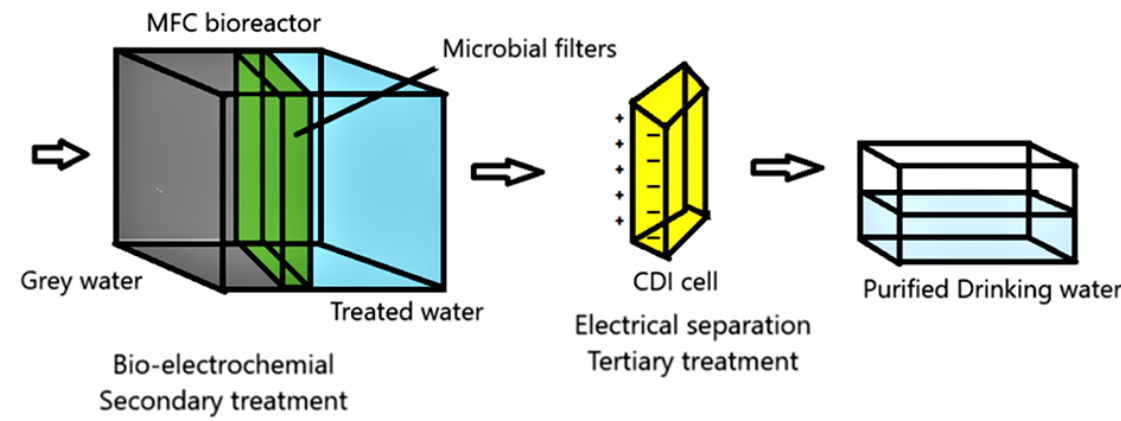
Figure 5. Green chemistry approaches for wastewater treatment through MFC